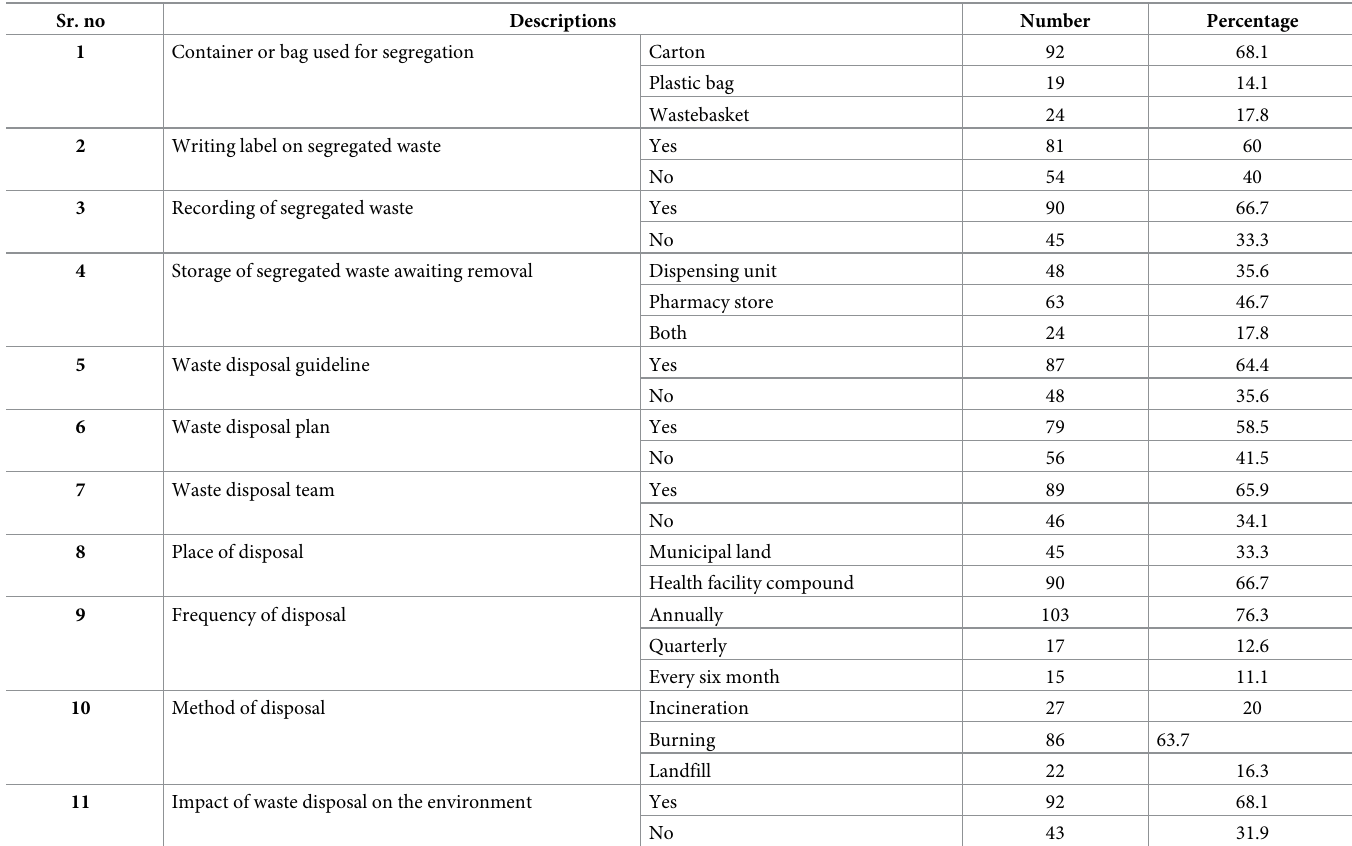
Table 5. Pharmaceutical waste management practices in public health facilities of Dessie town, Ethiopia, (n = 135). Sr.